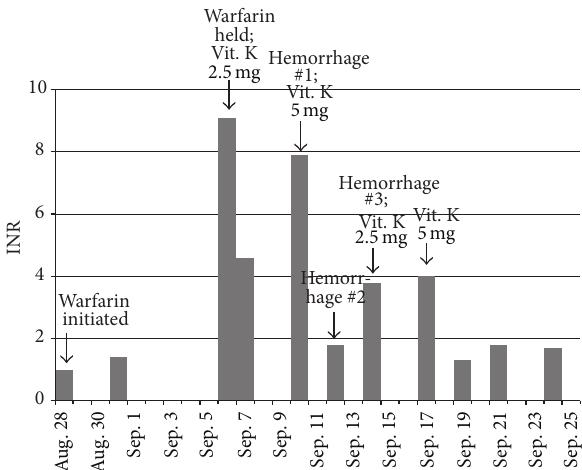
Figure 1: Timeline of INR and significant events after patient was initiated on warfarin 2mg per